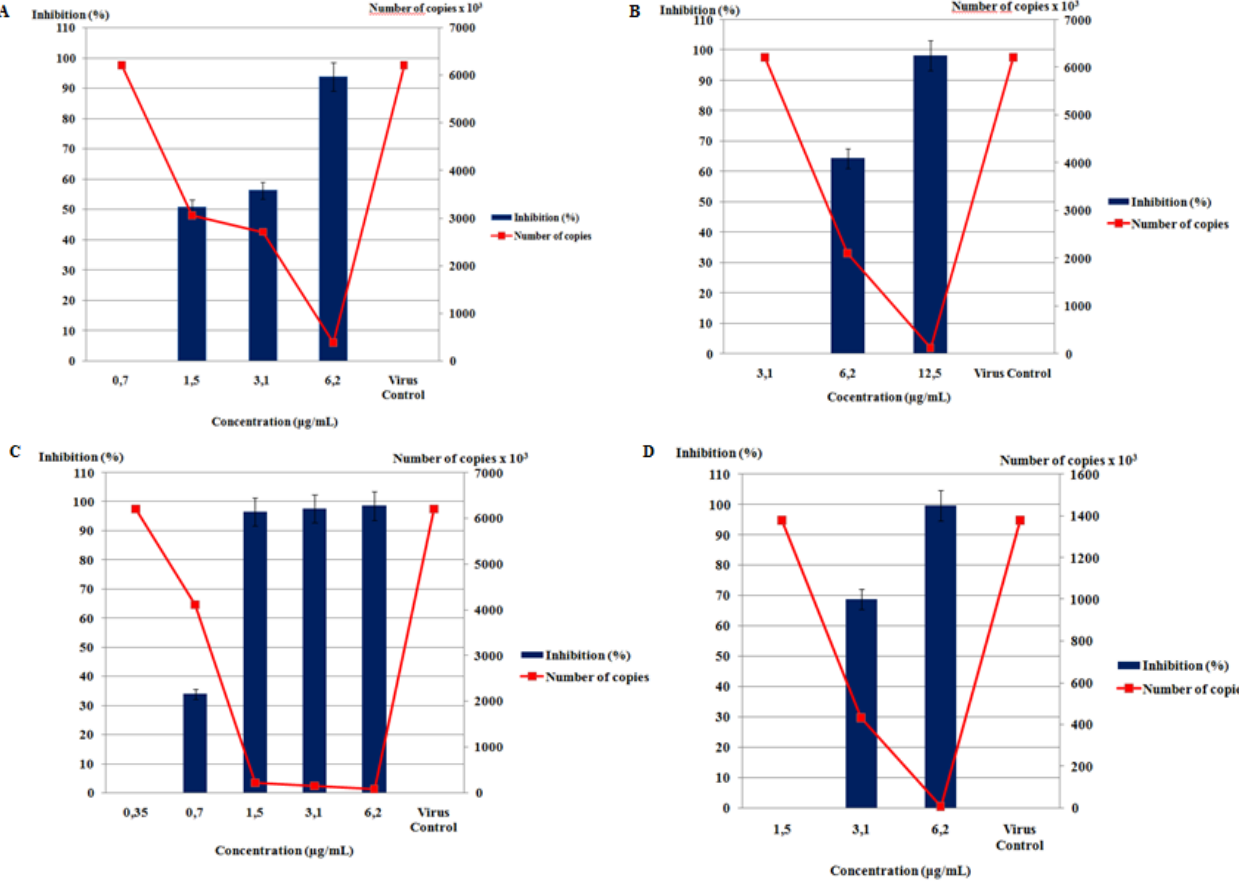
Figure 2. Kinetics of inhibition of the four compounds tested against HMPV. ( A ) S. zonale